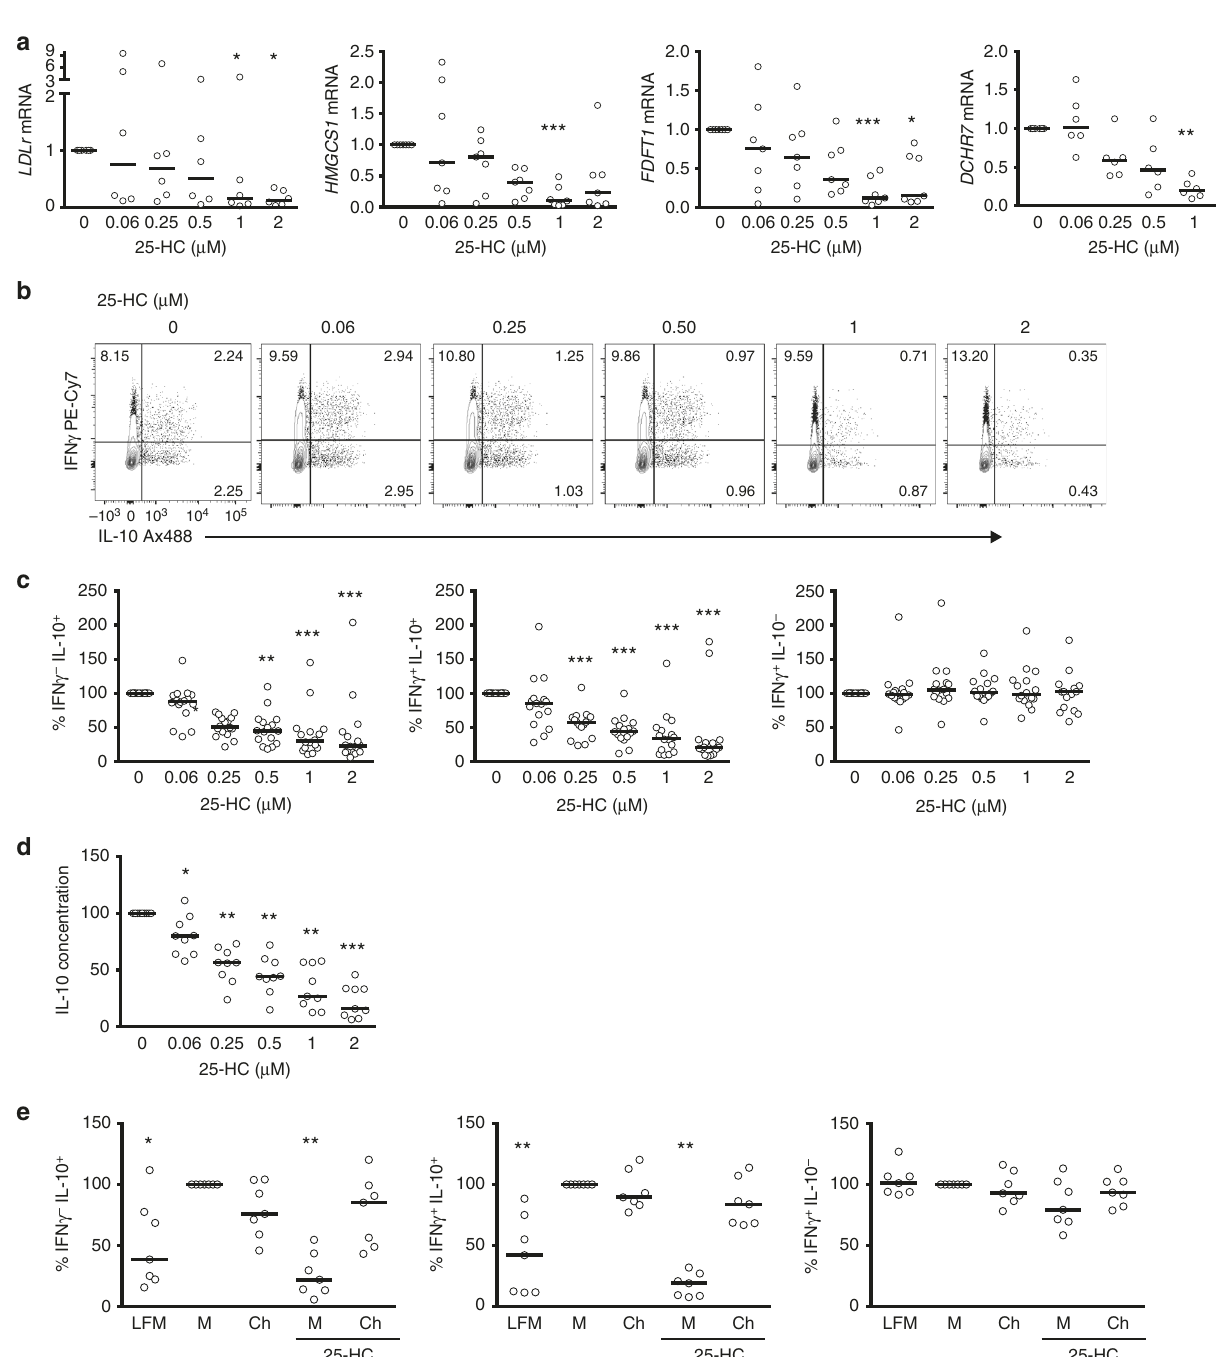
Fig. 4 Interleukin (IL-10) expression in T-helper type 1 (Th1) switching cells is dependent on intact cholesterol pathway fi tness. Puri fi ed human CD4 + T cells stimulated in vitro with plate-bound α -CD3 (2 μ gml − 1 ) + α -CD46 (5 μ gml − 1 ) and recombinant human interleukin-2 (rhIL-2) (50 Uml − 1 ) were cultured for 36 h in the presence of 25-hydroxycholesterol (25-HC). a Normalised LDLr , HMGCS1 , FDFT1 and DHCR7 messenger RNA (mRNA) levels ( n = 6 – 7). b Representative fl ow cytometric analysis of intracellular interferon- γ (IFN γ ) and IL-10 staining. c Normalised frequency of IFN γ − IL-10 + - (left), IFN γ + IL-10 + - (centre) and IFN γ + IL-10 − - (right) producing cells ( n = 16). d Normalised concentrations of secreted IL-10 ( n = 9). e Normalised frequency of IFN γ − IL-10 + - (left), IFN γ + IL-10 + - (centre) and IFN γ + IL-10 − - (right) producing cells cultured under lipid-free medium (LFM), fully supplemented medium (M) and cholesterol (500×) (Ch) in the presence or absence of 25-HC (2 μ M) for 36 h ( n = 7). Graphs show independent donors (dots) normalised to untreated cells; bars represent median values. *<0.05, **<0.01 and ***<0.001 denote a signi fi cant difference compared to untreated cells by Friedman test with post hoc Dunn ’ s correction ( a , c : IFN γ − IL-10 + , e ) or by repeated-measures one-way analysis of variance (ANOVA) test with post hoc Dunnett ’ s correction ( c : IFN γ + IL-10 + and IFN γ + IL-10 − , d